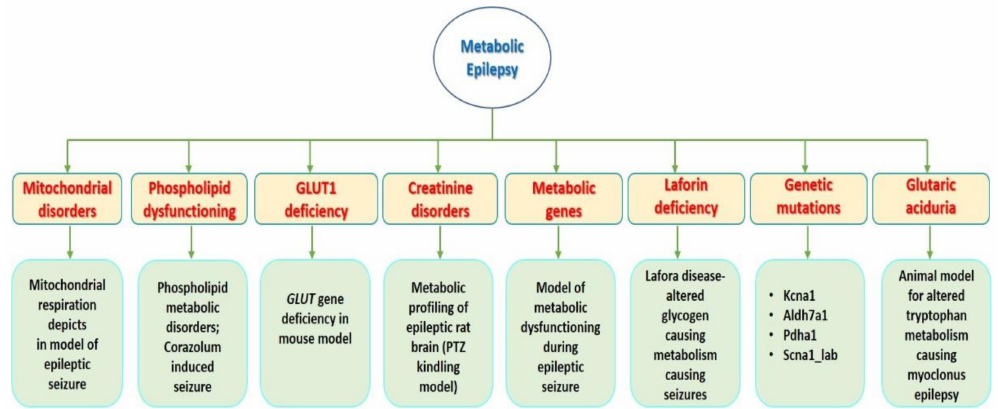
Figure 2. Animal models of ME and epilepsy associated metabolic dysfunctions: This figure demonstrates the overall studies of animal model related to ME with di ff erent multi approach considered in the current